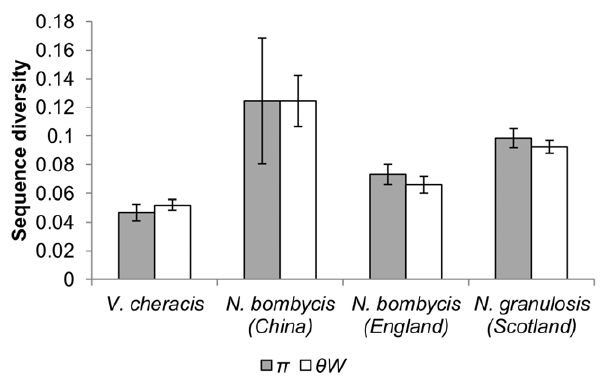
Table 2. Population structure of ribosomal IGS sequences from N. bombycis , N.granulosis and V. cheracis isolates.